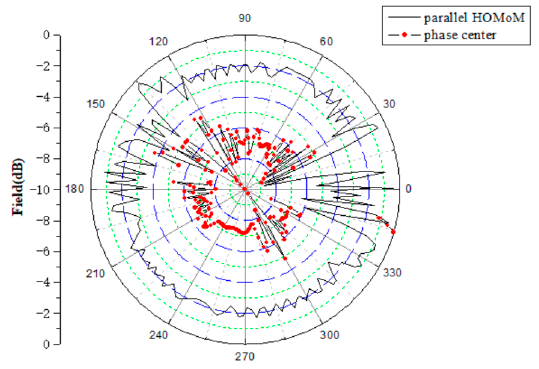
Figure 9. Disturbed pattern on xoz plane calculated by phase center.